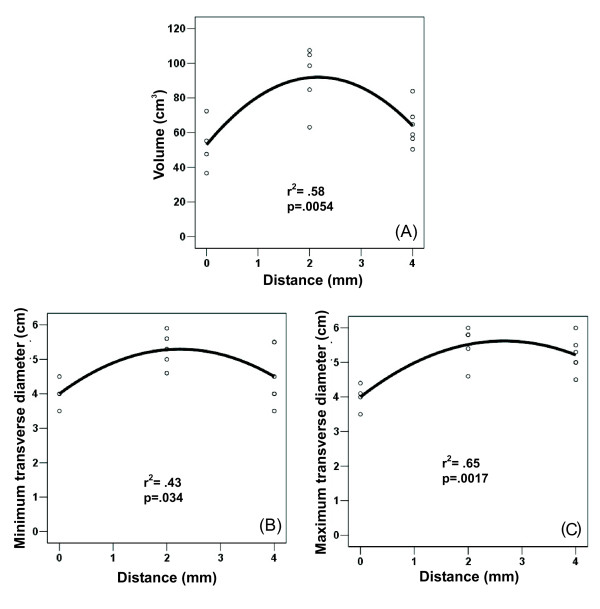
Effect of perfusion distance on volume coagulation and coagulation diameters. Three values of perfusion distance were tested: 0 mm (n = 4), 2 mm (n = 5) and 4 mm (n = 6). Scatter plot shows non-linear (quadratic) relationship between distance and coagulation volume (A), maximum transverse diameter of coagulation (B), and minimum transverse diameter (C). Goodness of fit of the models is individually assessed by r2. Note the improved effect at 2 mm distance.